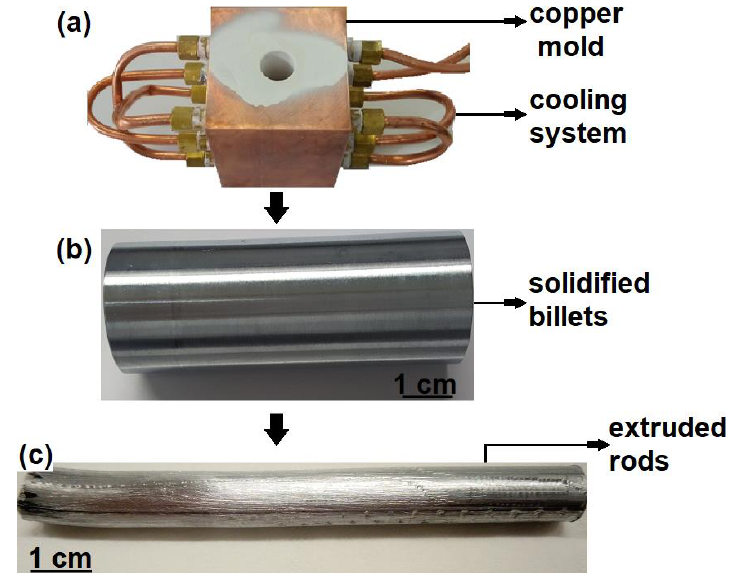
Figure 1. ( a ) Cu-mold coupled with a water cooling system, ( b ) a typical billet in the as-cast condition after machining for the removal of the oxidized external layer, and ( c ) a typical rod in the as-extruded condition.